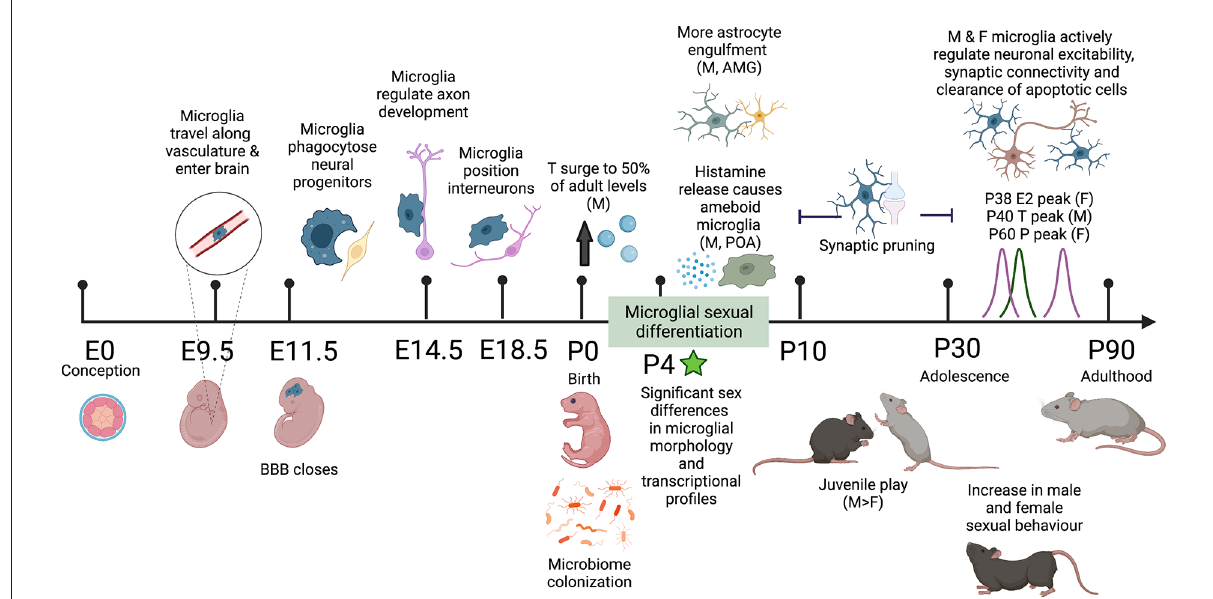
FIGURE1 Schematic timeline of the sex differences observed in mouse microglial development and adult behavior. Microglia colonize the brain along the vasculature at E9.5 and fully colonize the brain by E11.5 upon closure of the blood-brain barrier (BBB). In embryonic development, microglia perform a range of organizational functions in the healthy brain. Male and female microglial transcriptomes are comparable throughout embyrogenesis but significantly diverge after birth, correlating with male testosterone (T) surge and microbiome colonization in both males and females. By P4 significant sex differences in microglial morphology are observed including more ameboid microglia and more microglial- astrocyte engulfment in males compared to females. Between P10 and P30 both male and female microglia undergo synaptic pruning. During this adolescent period, males display more juvenile play behavior. In early adulthood, there are observed increases in male and female sexual behavior along with peak levels of sex hormones: T in males and estradiol (E) and progesterone (P) in females. In the healthy adult mouse brain, microglia self-proliferate for the rest of life, continuing to sense and respond to their local environment and regulate neuronal excitability, synaptic connectivity, and clearance of apoptotic cells. Differential programming of microglia early in life alters their responses to immune challenges throughout life and may play a role in sex-biased prevalence rates in neurodevelopmental and neuropsychiatric disease. Created with